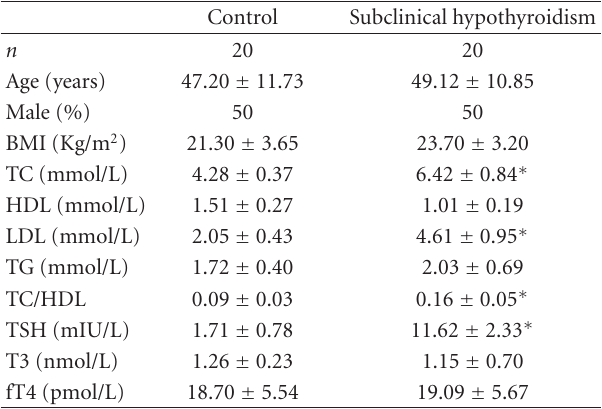
Table 1: Clinical and laboratory data of study participants.